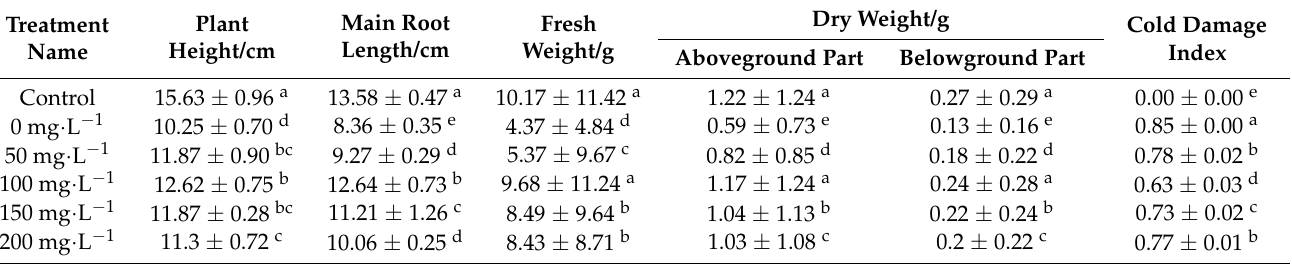
Table 1. Changes in the growth characteristics of peanut seedlings with exogenous chitooligosaccha- ride under simulated low-temperature